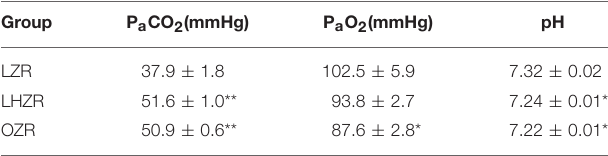
TABLE 1 | Blood gas analysis during exposure to room